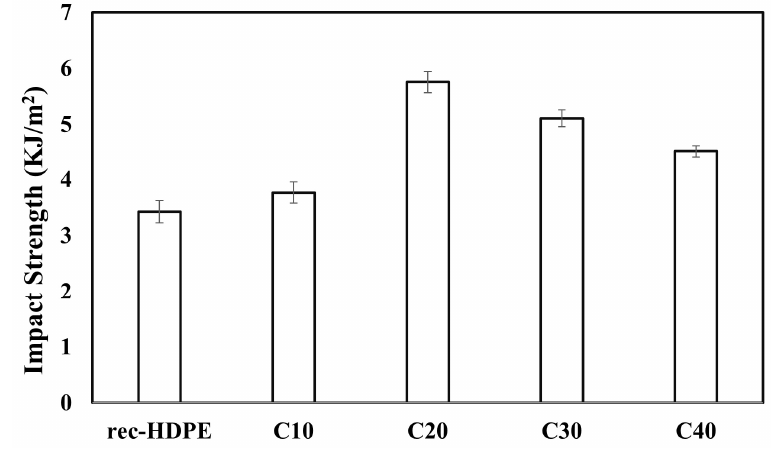
Figure 5. Impact properties of the recycled HDPE and composites. Table 3. Mechanical properties of the recycled HDPE and composites.